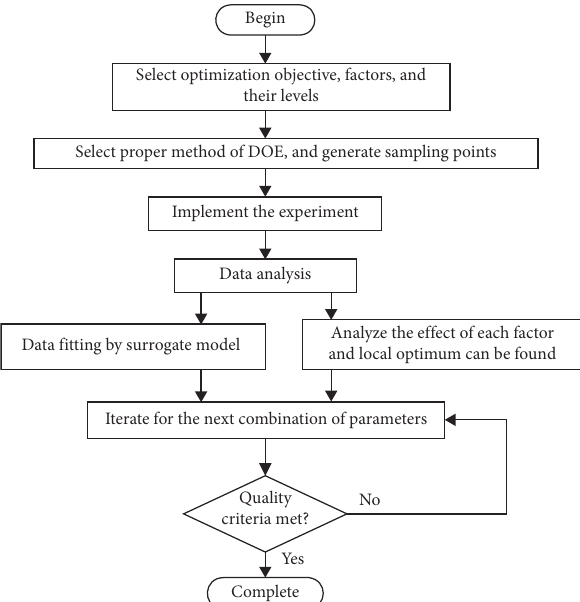
Figure 10: A flowchart of the overall optimization of injection molding